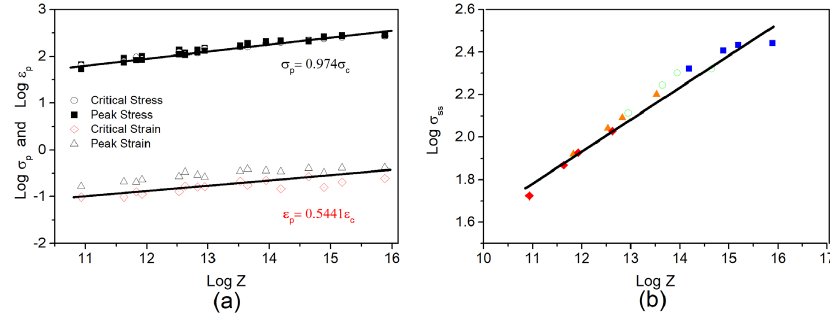
Figure 10. Linear relationship between (a)